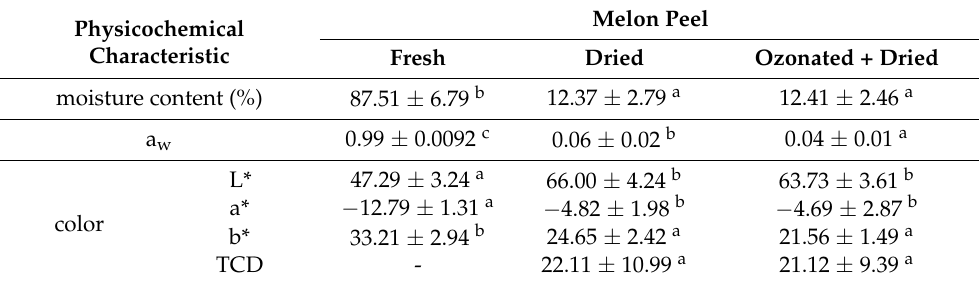
Table 1. Selected physicochemical characteristics of fresh and freeze-dried melon peel, with and without ozone pre-treatment. The values are mean ± margin of confidence intervals at 95%.